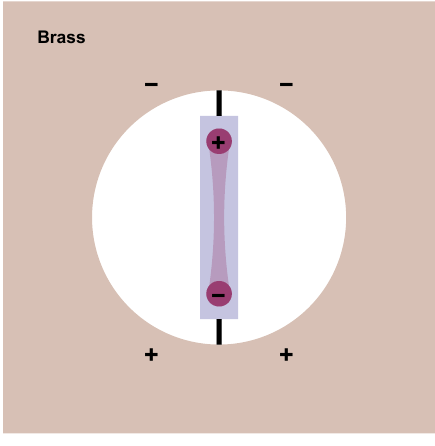
Figure 8 . The quirk pair as an AC battery in brass (the CMS calorimeter material). The oscillating charges draw electrons to one side, then back